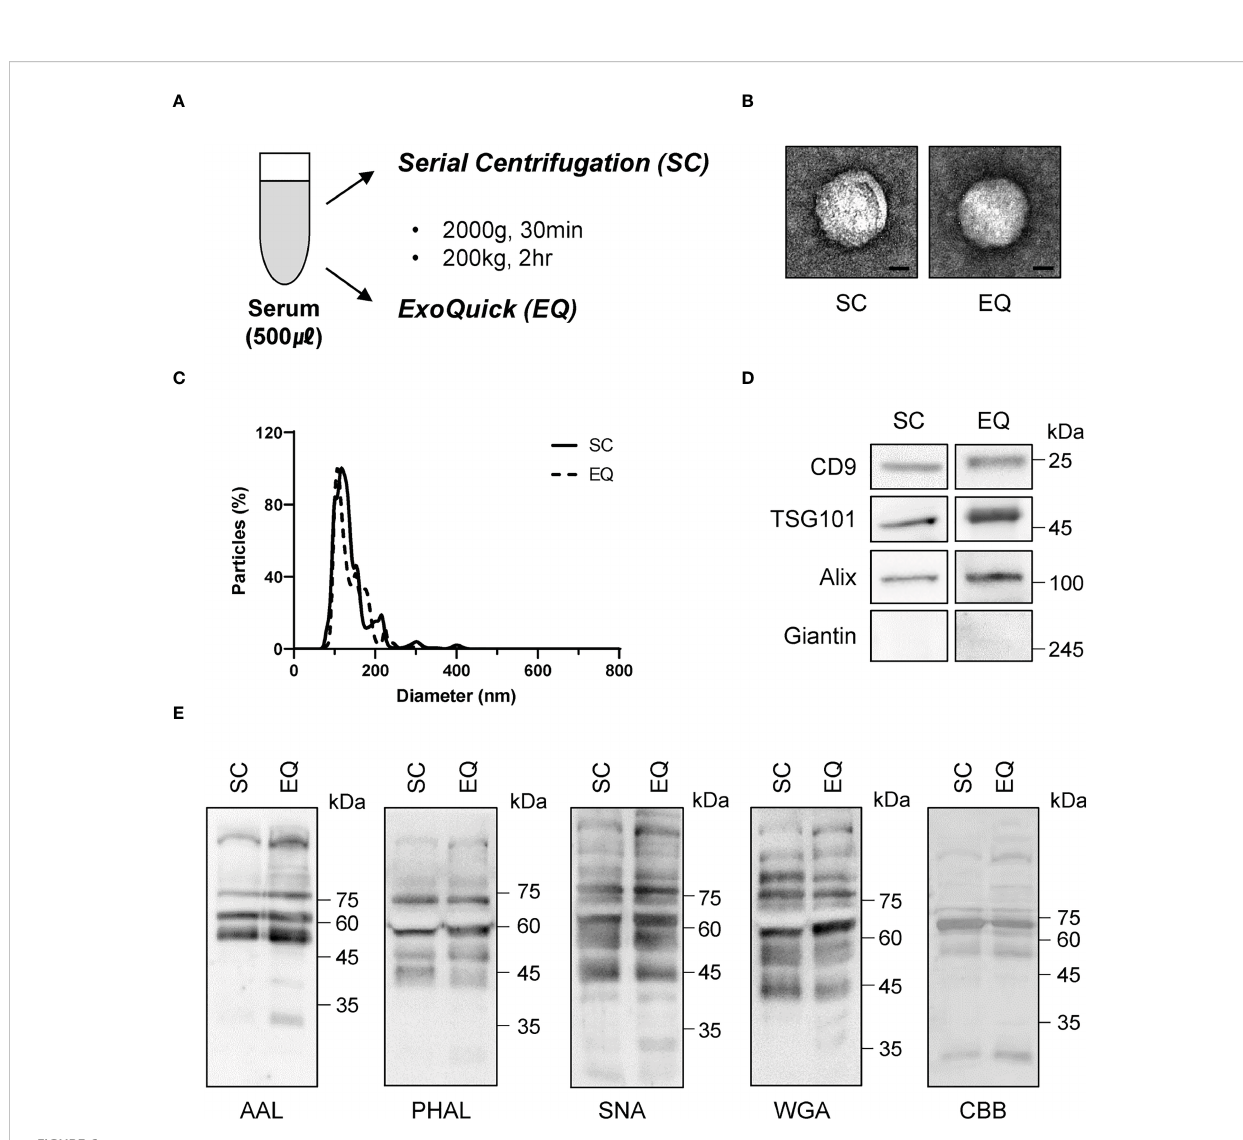
FIGURE 6 Comparison of glycosylation between EVs isolated via two different approaches. (A) Schematic of the EV isolation methods. SC, serial centrifugation. EQ, ExoQuick. (B) Electron microscopy (EM) assessment of the size and morphology of isolated EVs. Representative images are shown. Scale bar = 20 nm. (C) Nanoparticle tracking analysis for the quantitation of EV size. (D) Western blotting using antibodies against EV components. n = 3. (E) Lectin blot assessing the glycosylation pro fi les of isolated EVs. The blotted membrane was stained with Coomassie Brilliant Blue, n =